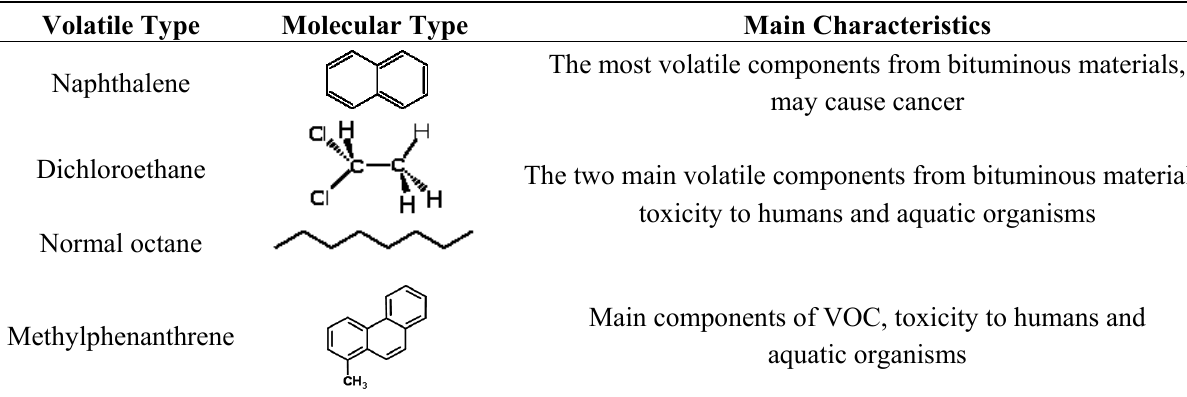
Table 3. Information for the four analyzed VOCs.